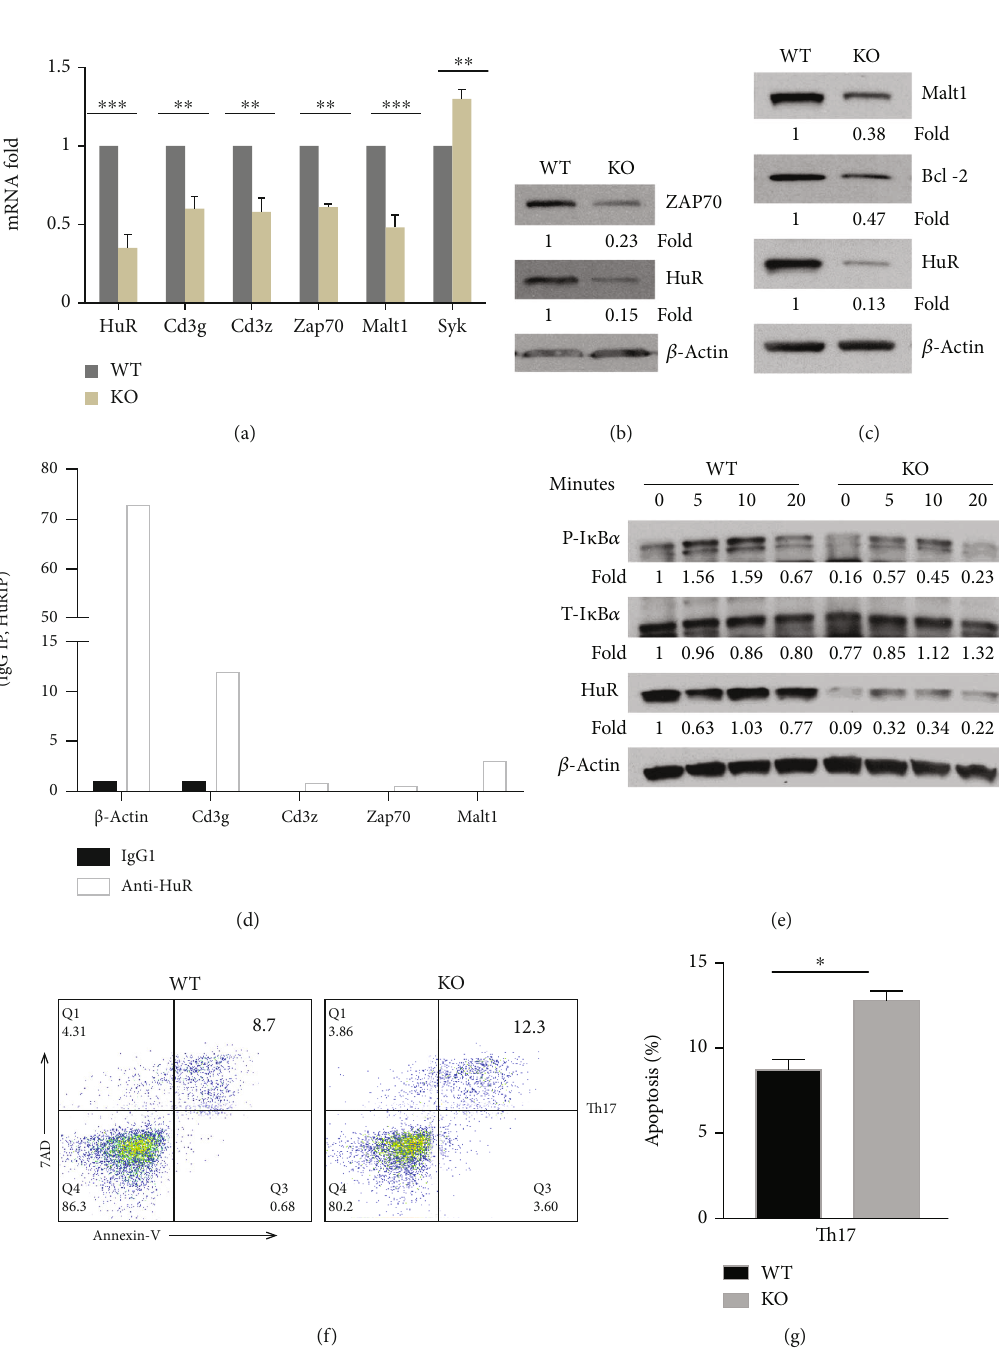
Figure 2: HuR modulates TCR/CD3 complex signaling in Th17 cells. Naïve CD4 + T cells from the spleen of WT and HuR KO mice were isolated and cultured under Th17 cell polarization conditions as described in Materials and Methods. The polarized cells were collected for further experiments at 4-5 days after culture. (a) Total RNAs were extracted and reversely transcribed into cDNA. The mRNA levels were analyzed by RT-qPCR. (b, c) Knockout of HuR decreased Zap70, Malt1, and Bcl-2 abundances detected by western blot assay. (d) RIP assay was performed to determine if CD3g, Zap70, and Malt1 mRNAs were associated with HuR protein in Th17 cells. One representative experiment result is known here. The repeated RIP experiment also got the same tendency of results. (e) Naive WT and HuR KO CD4 + T cells were cultured at Th17 cell polarization condition for 3 days. Then, Th17 cells were rested 2 days in the presence of IL-2 (3ng/ml) following restimulation by Th17 cell-polarizing cytokines (TGF- β +IL-6) without IL-23 for the indicated times. The level of phosphorylated proteins were detected by western blot assay. (f) There is a little di ff erence between HuR KO Th17 cells and WT Th17 cells susceptible